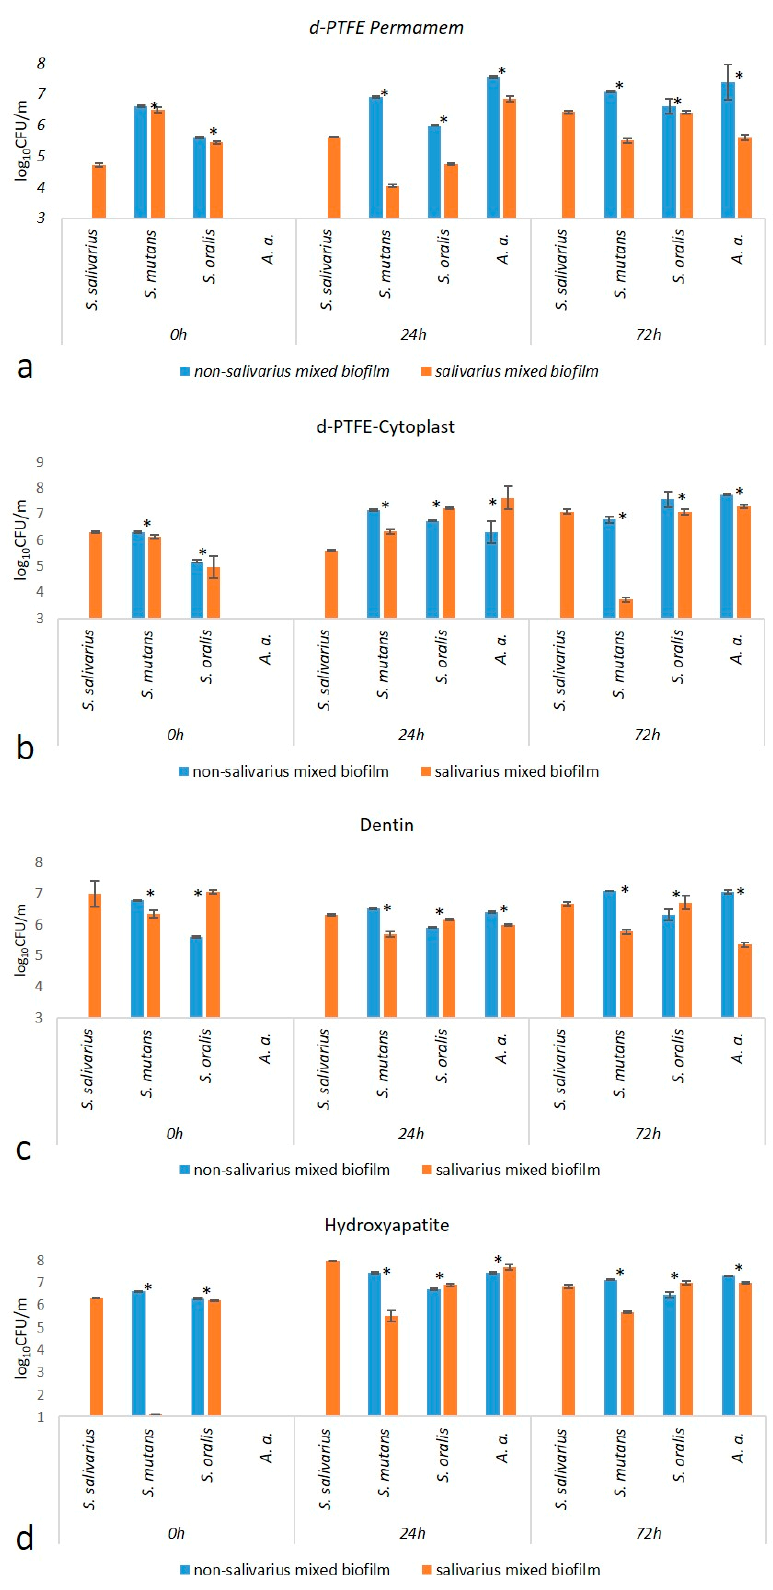
Figure 1. Comparison of the number (log 10 CFU/mL) of individual bacterial species in non-salivarius and salivarius mixed biofilms on: ( a ) Permamem, ( b ) Cytoplast, ( c ) Dentin and ( d ) Hydroxyapatite. 95% CI—95% Confidence interval: * Mann–Whitney U